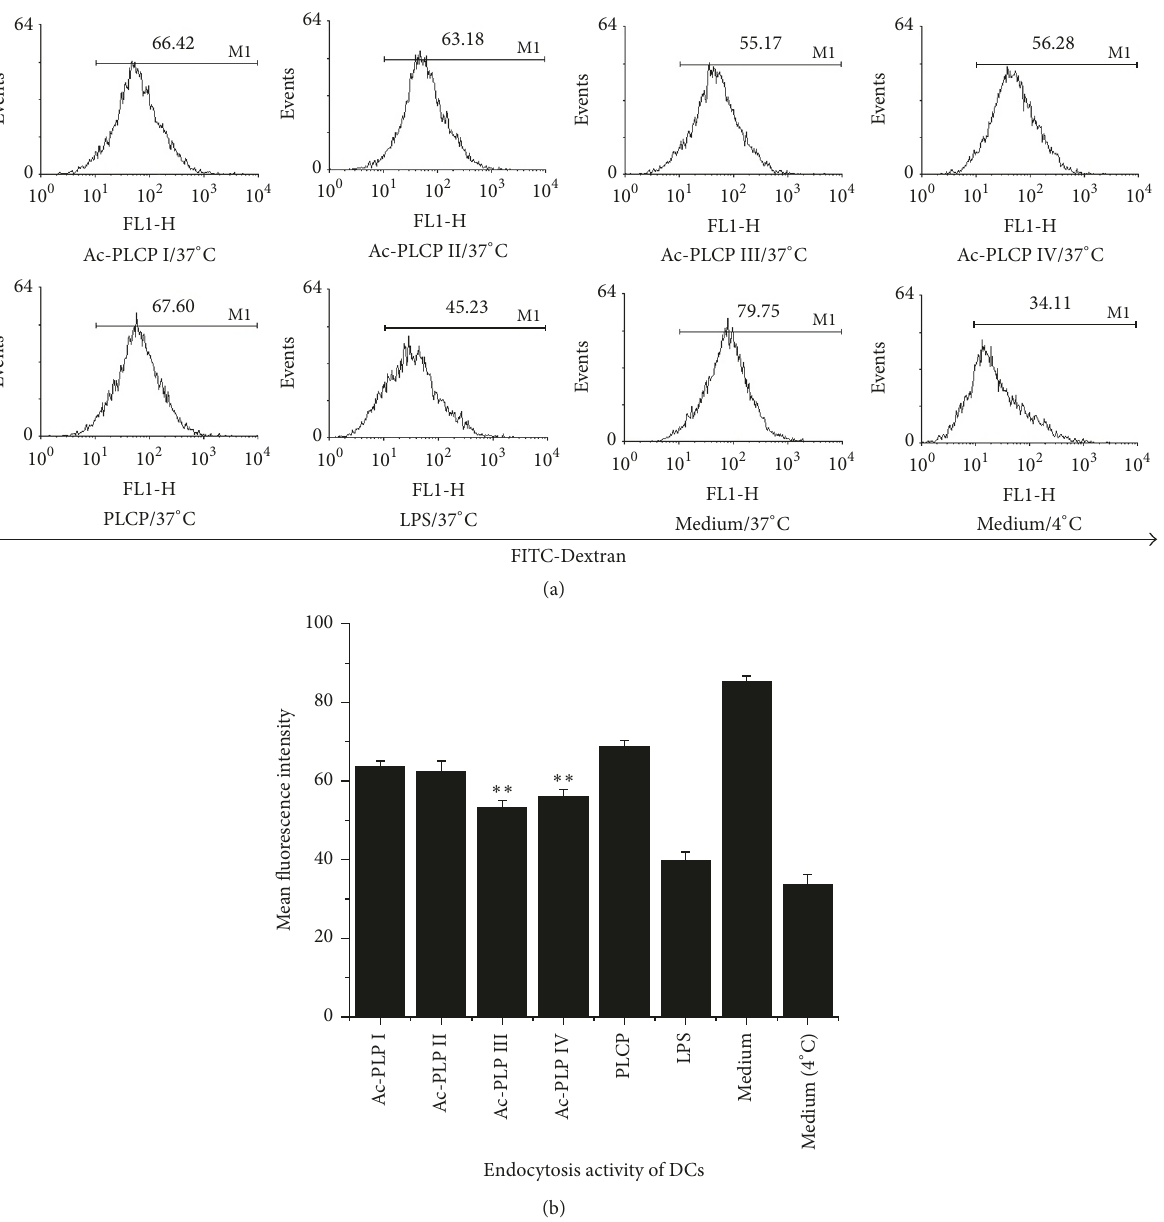
Figure 4: Ac-PLCP attenuated the endocytosis activity of DCs. The endocytosis activity was also determined by flow cytometry. The uptake of FITC-dextran of DCs in medium group was extremely high. However, endocytosis activity was significantly attenuated by PLCP treatment. In particular,DCsinAc-PLCPIIIandIVgroupsexhibitedmuchweakeruptakeofFITC-dextran.Theresultsshownwerefromonerepresentative experiment of three independent experiments performed. ∗∗ 𝑃 < 0.01 compared to the PLCP